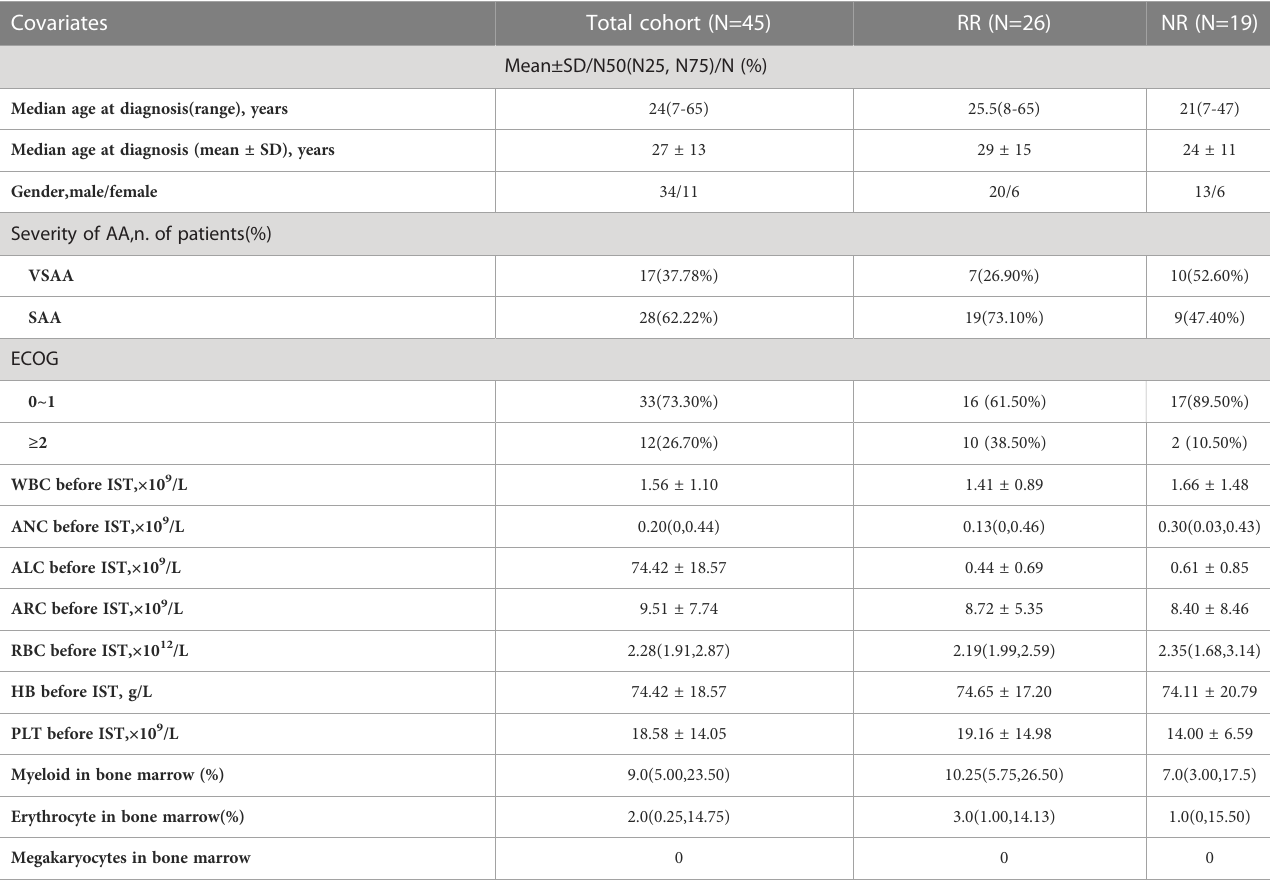
TABLE 1 Baseline clinical and laboratory characteristics.